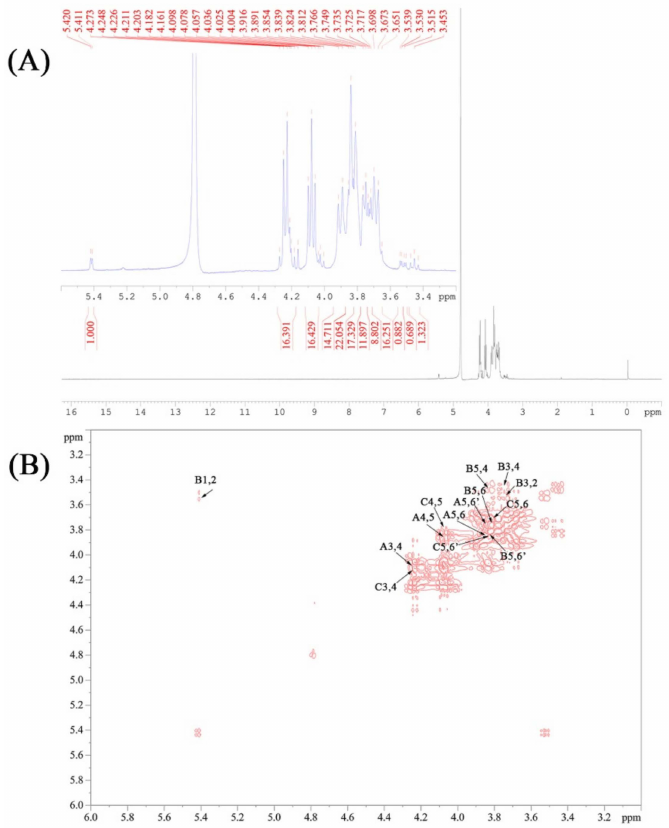
Figure 4. The 1 H ( A ) and COSY ( B ) NMR spectra of the